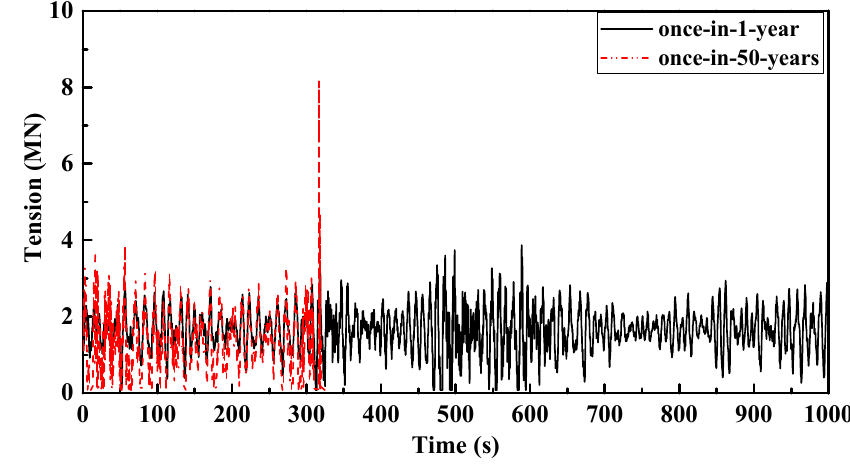
Figure 16. Time series of tension in the No. 1 mooring line under extreme sea-states.